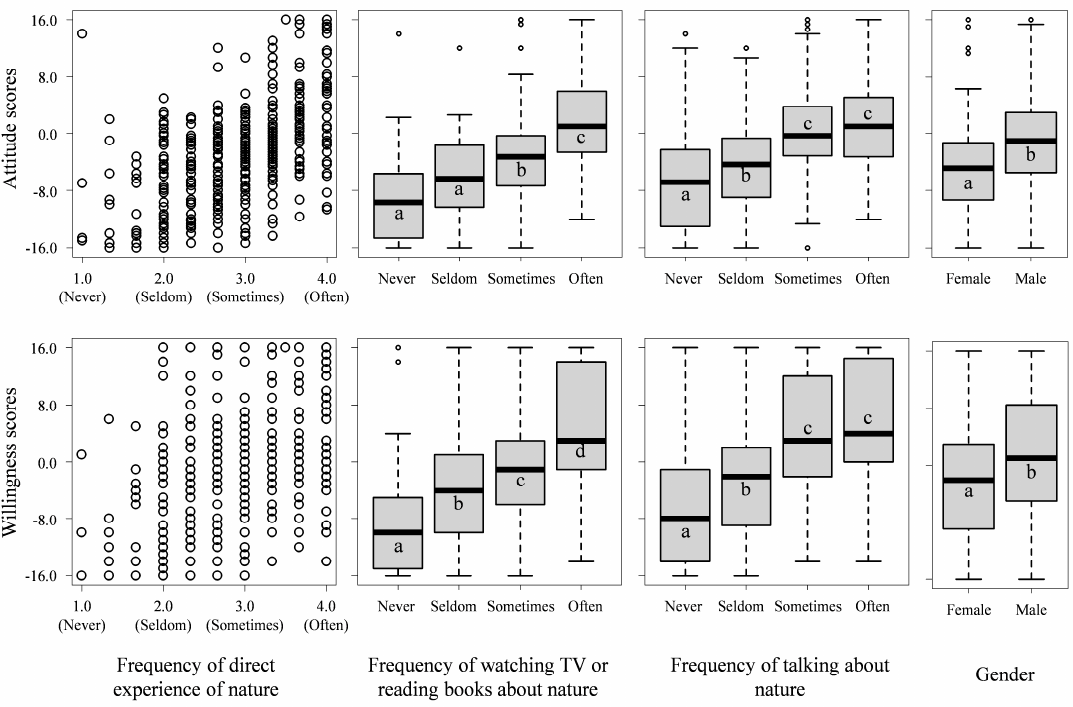
Figure 2. Relationships between the frequency of direct and vicarious experiences of nature, gender, and affective attitudes towards (attitude scores) and willingness to conserve biodiversity (willingness scores). The central bars in the box plot indicate the median, the ends of the boxes indicate the interquartile range, and the whiskers indicate the 10th and 90th quantiles. Different letters indicate significant differences between groups of data according to ANOVA with Tukey’s HSD test (see also Table S1).